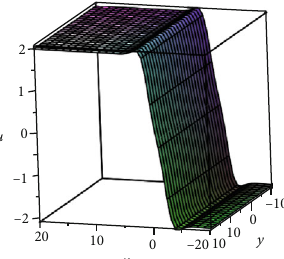
Figure 3: Spatiotemporal structure of solution (14) with the parameter selections a 1 = 1 , a 5 = 1 , a 7 = 1 , k 1 = 1 , k 2 = 1 , and δ 4 = 1